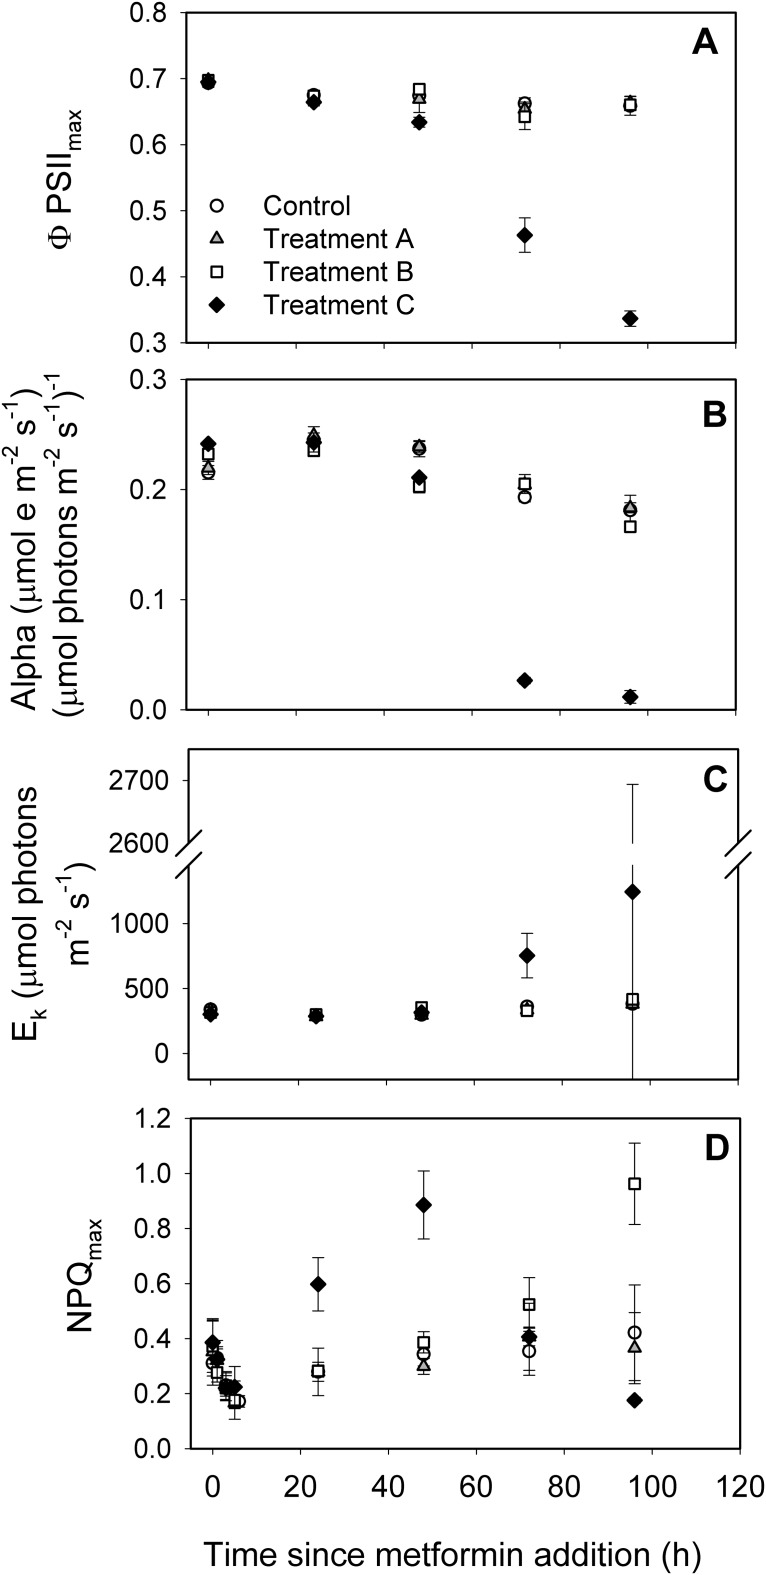
Effects of metformin on photosynthetic parameters of C. vulgaris over 96 h of exposure for four treatment levels: No addition (Control, open circles); 1.5 mg L-1 (Treatment A, open triangles); 76.8 mg L-1 (Treatment B, open squares); and 767.8 mg L-1 (Treatment C, closed diamonds).Parameters include (A) maximum yield of PSII (ΦPSIImax), (B) electron transport efficiency (initial slope of the ETR curve, α), (C) minimum saturating irradiance (Ek), and (D) maximum nonphotochemical quenching (NPQmax).